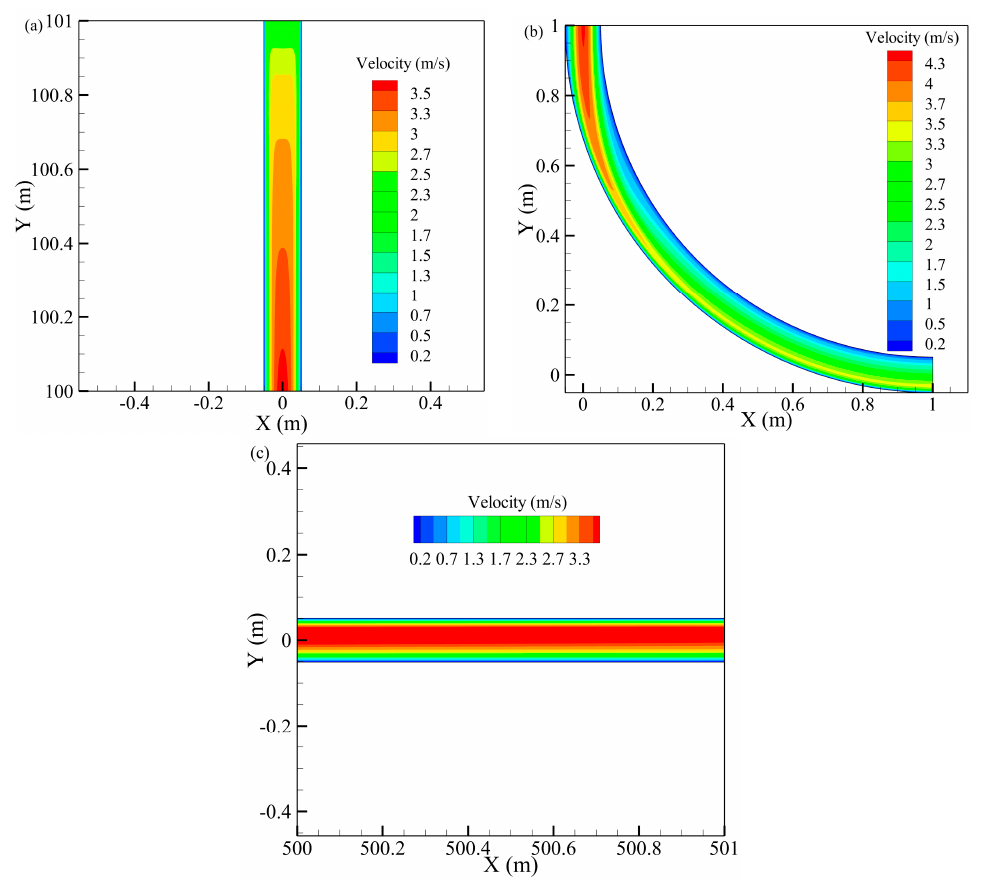
Figure 12. Velocity distributions in the pipe for a bubble volume fraction of 15 vol %: ( a ) inlet, ( b ) elbow, and ( c ) outlet.